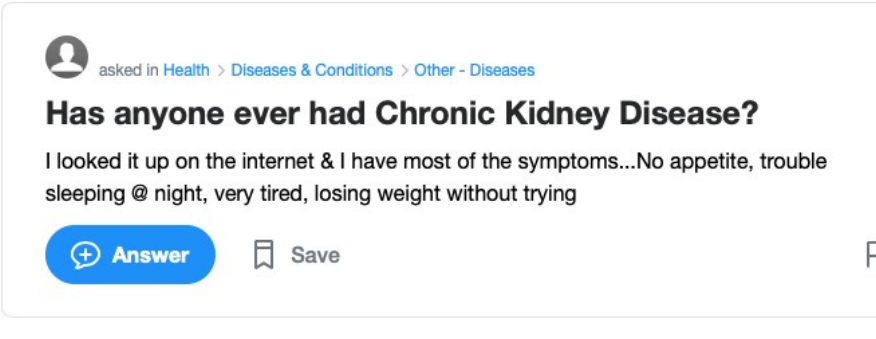
Figure 1. Illustrations of information seeking and sharing behavior in single-disease health questions.